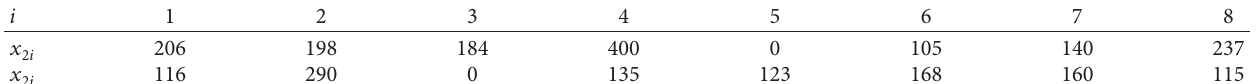
Table 5: The optimal production scheduling.